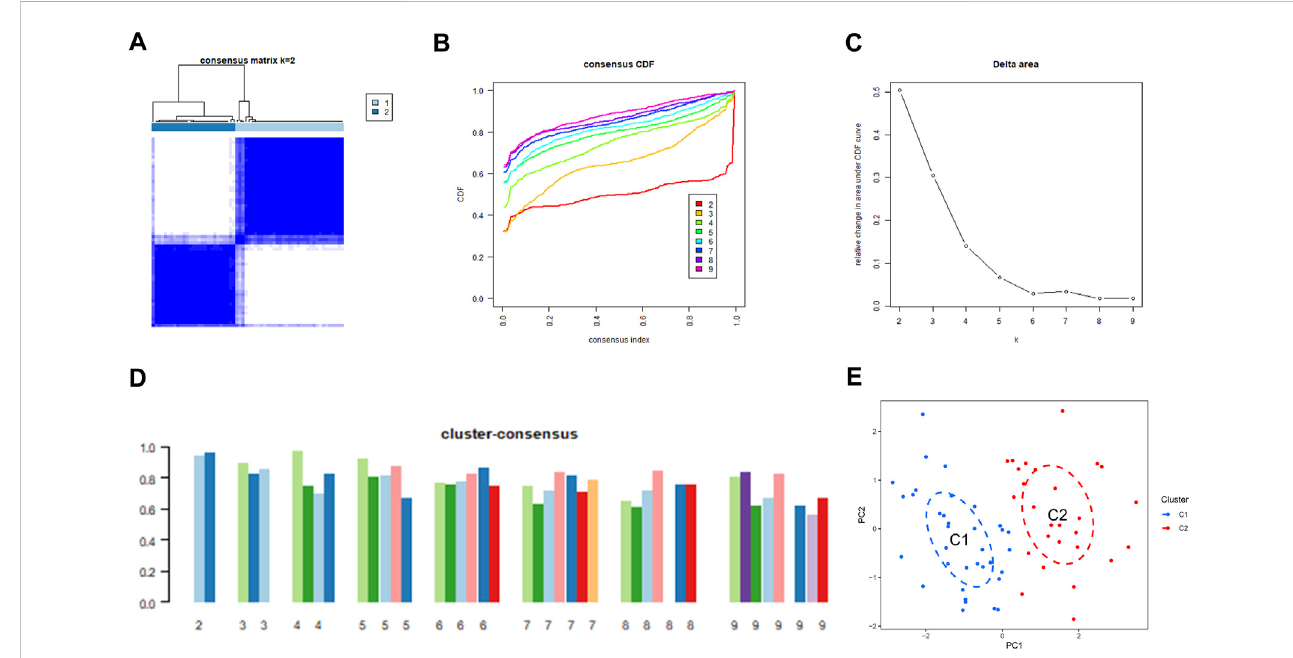
FIGURE 3 Identi fi cation of ER stress-related molecular clusters in BPD. (A) Consensus clustering matrix when k = 2. (B – D) Representative CDF curves. (E) PCA visualizes the distribution of two